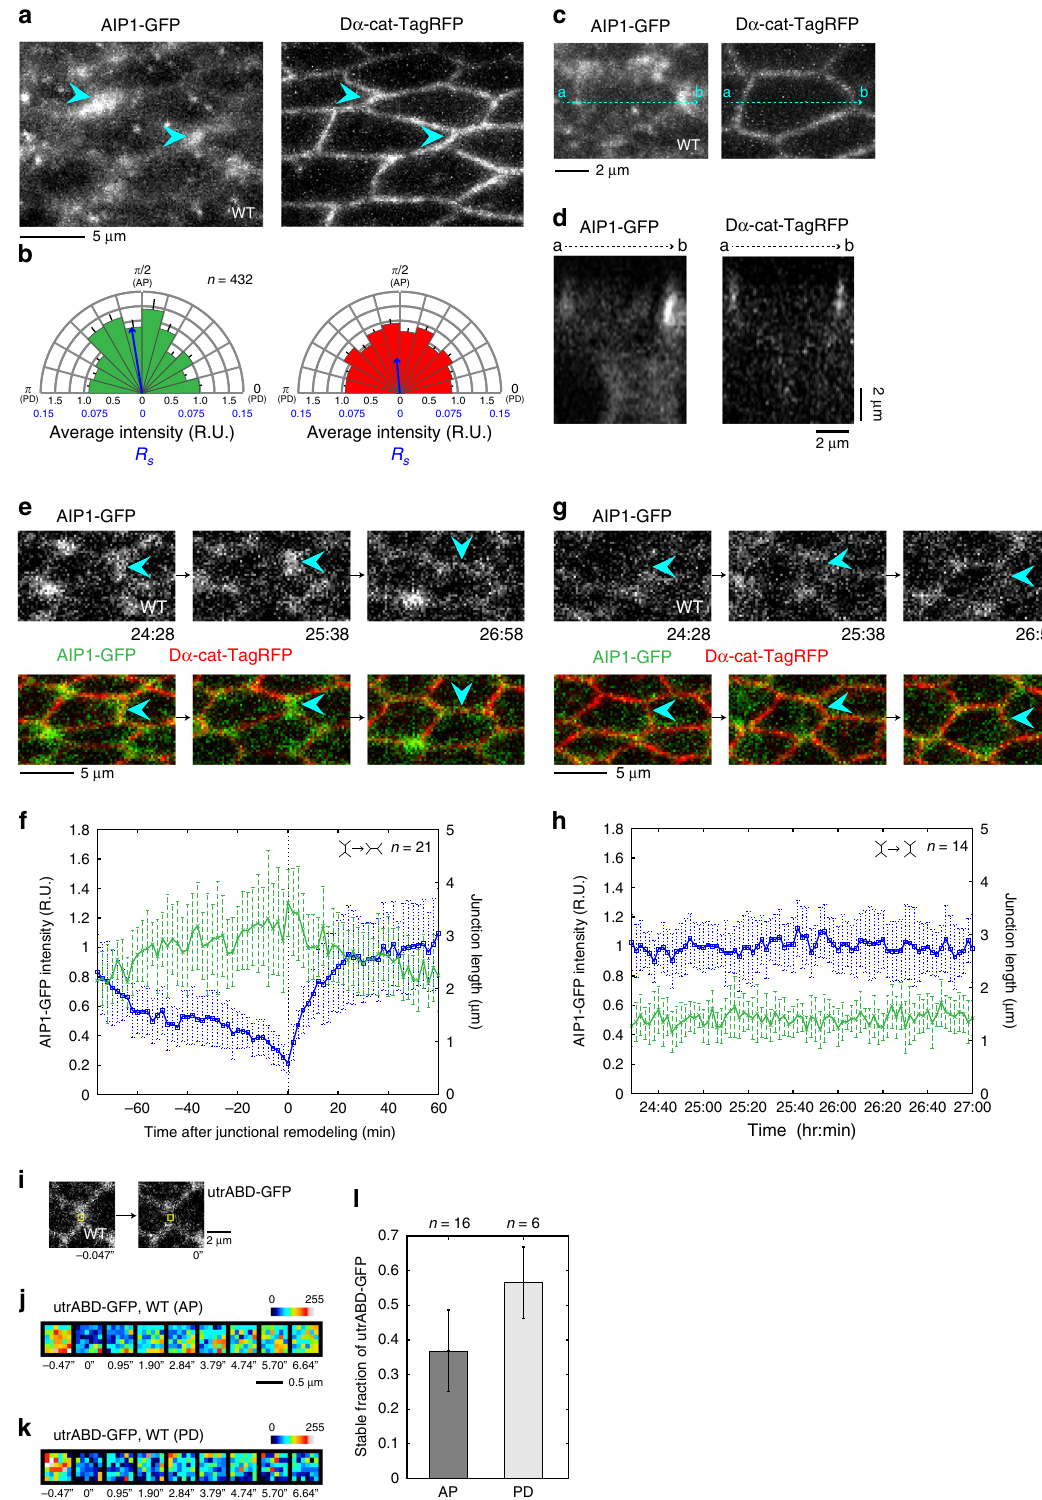
the change in F-actin localization. For comparison, the same experiment was performed with another ABP, Enabled (Ena), which promotes the elongation of actin fi laments 41 . As shown in Fig. 3g, h, Ena retained its localization at junctions and vertices in the absence of an extrinsic stretching force. Thus, tissue tension-